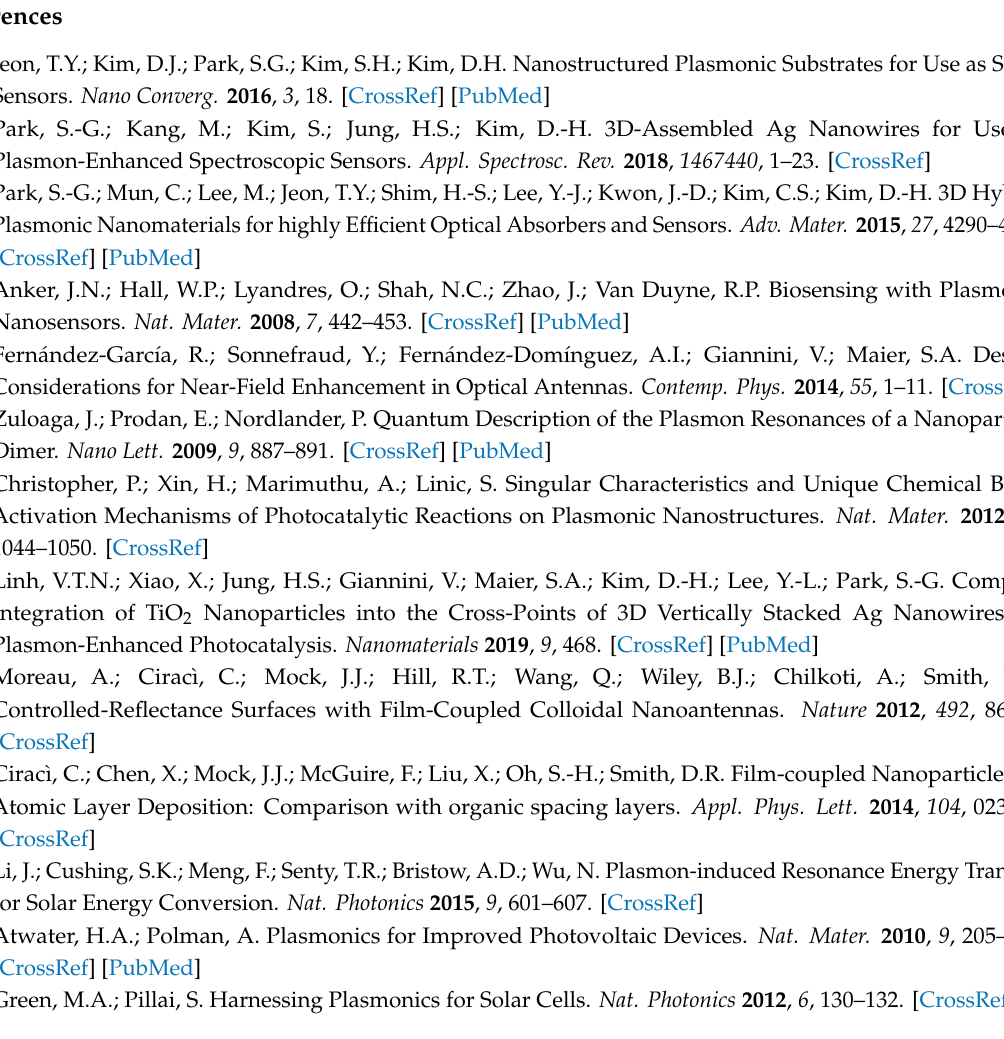
Figure S1: FE-SEM images of the polyethylene terephthalate (PET) nanopillars treated with an Ar plasma for 60 s; Figure S2: A water contact angle of 72 ◦ was obtained on the Ag / PET hybrid nanostructures; Figure S3: SEM images of (a) the non-leaning and (b) leaning Ag NPs; Figure S4: SERS spectrum measured from the benzenethiol monolayer-treated leaning Ag NPs (red line), and the normal Raman spectrum obtained from the pure benzenethiol solution (black line); Figure S5: The SEM image indicated that the PDMS membrane was 186 µ m thick. Figure S6: Raman spectrum of